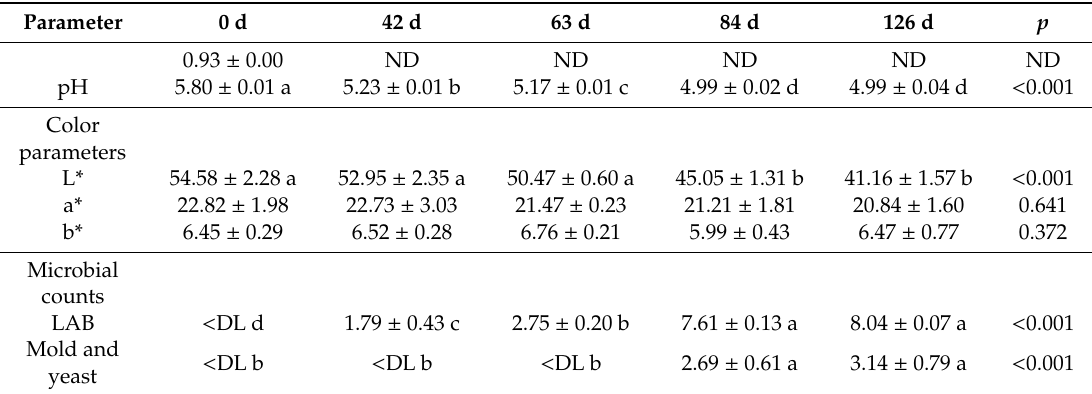
Table 3. pH, color parameters, and microbial counts of sliced cured loins through storage duration (mean ± standard deviation of log cfu / g, n =